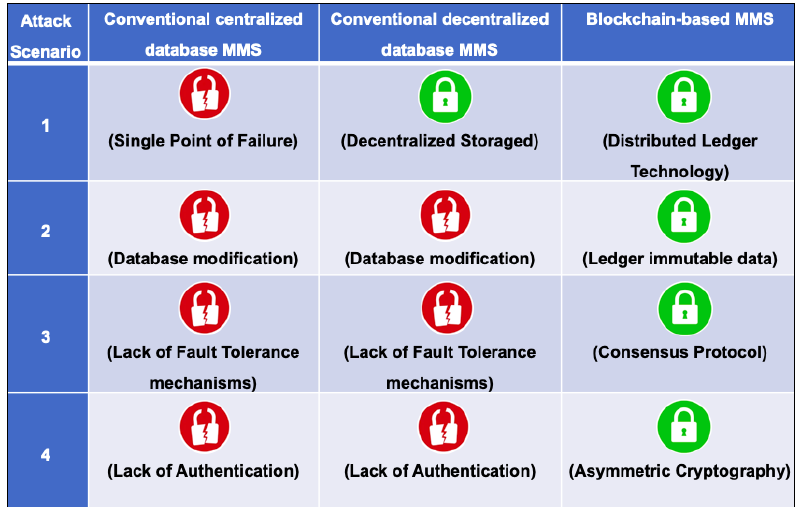
Figure 4. Security